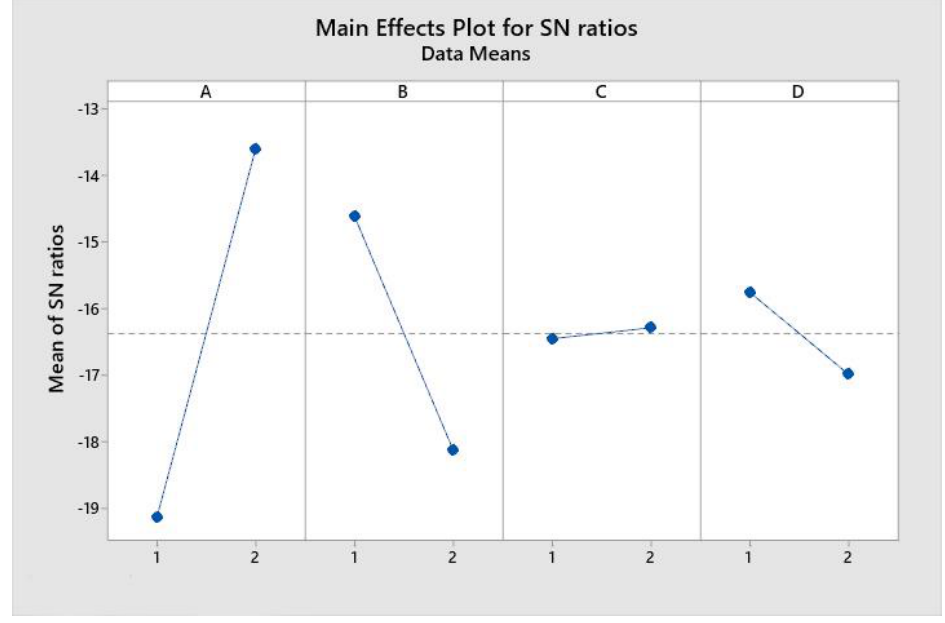
Figure 8. System optimization by configuring parameters, according to the Taguchi method.